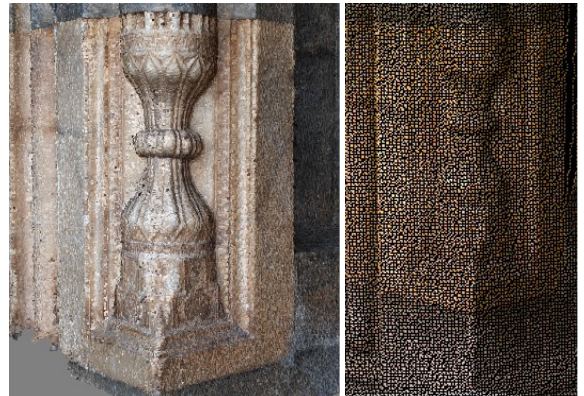
Figure 6. 3D visualization by SfM (on the left) and TLS point clouds.